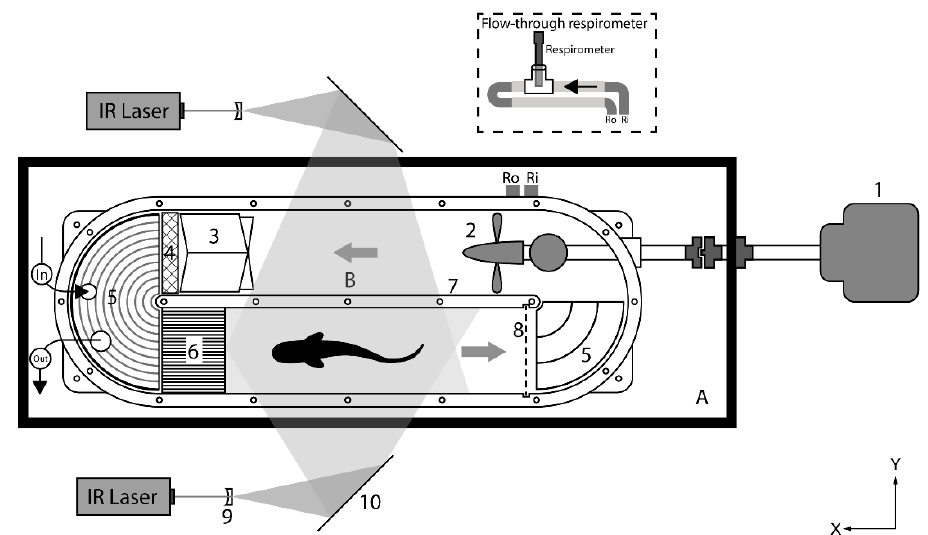
Figure 1. Modified Brett-type swim tunnel respirometer used for particle image velocimetry (PIV) and respirometry experiments (top view). PIV experiments were conducted without the optional flow-through respirometry loop (Ro and Ri closed) but included a high-speed camera mounted on top of the test section and pointing down. ( A ) Buffer tank, ( B ) swim tunnel respirometer, ( 1 ) motor, ( 2 ) impeller, ( 3 ) fin-type flow straightener, ( 4 ) back-flow dampener/disturbance plate (coarse filter), ( 5 ) flow straightener (vanes), ( 6 ) honey-comb flow straightener, ( 7 ) transparent acrylic wall, ( 8 ) metallic mesh, ( 9 ) plano-concave lens, ( 10 ) mirror.